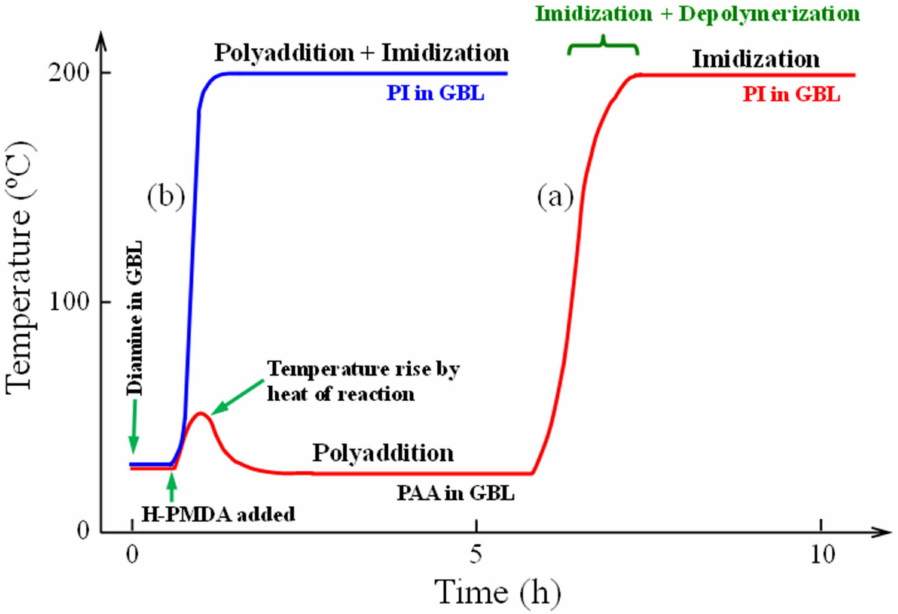
Figure 8. Reaction temperature profiles of one-pot polymerizations heated at different timings: ( a ) conventional process and ( b ) modified process used in this